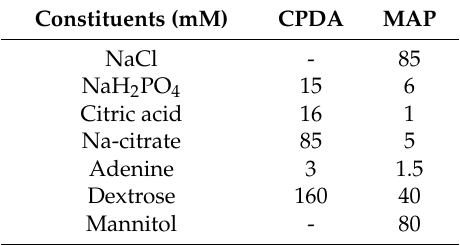
Table 2. Composition of blood anticoagulant and RBC additive